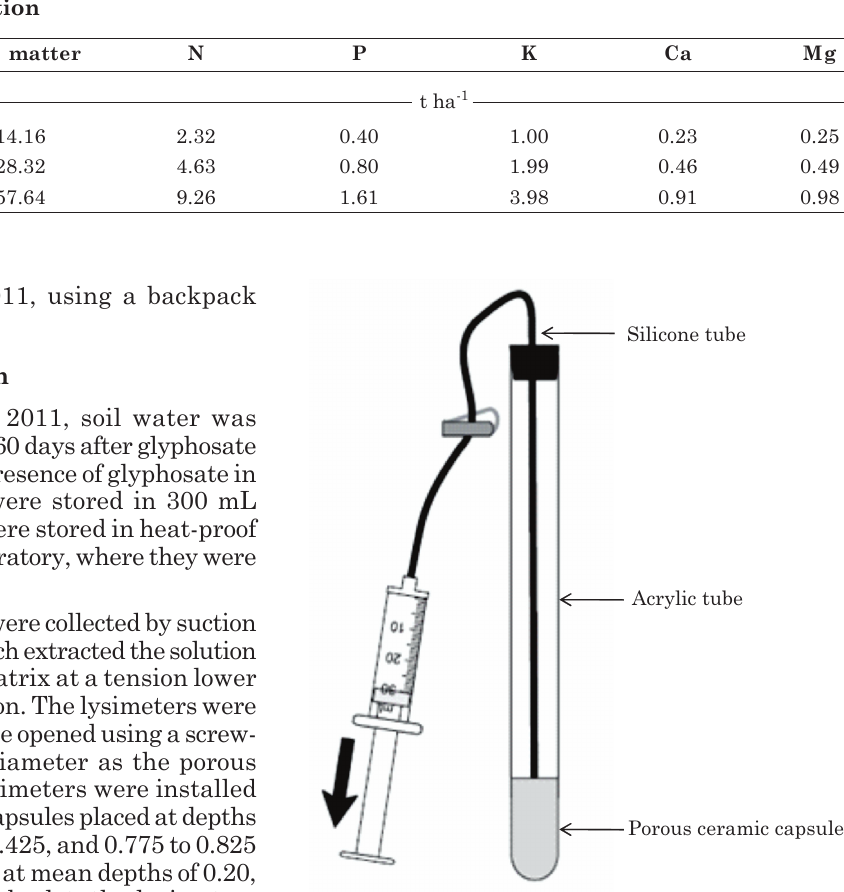
Figure 1. Suction lysimeter used for sampling soil solution.